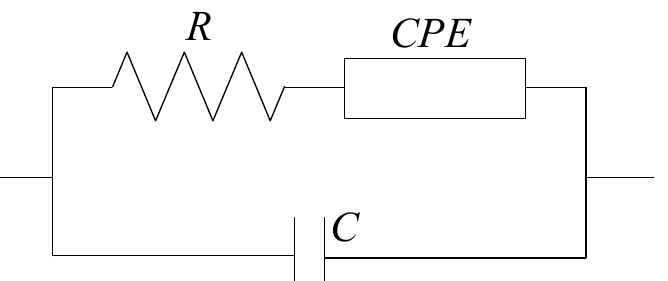
Figure 7. Equivalent circuit of milk. The constant phase element ( CPE ) models the interface electrode/milk; the capacitance C represents the capacitance of the two electrodes separated by the characterized milk; the resistance R represents the milk conductance.